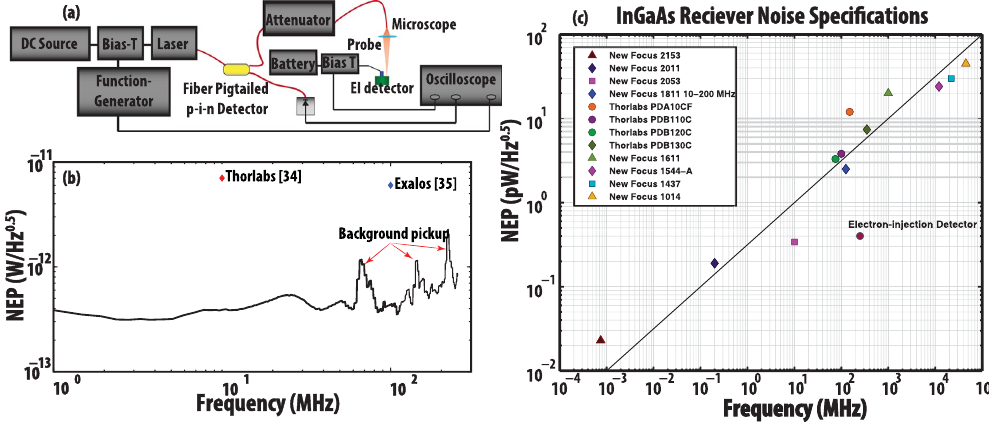
Figure 1. ( a ) Small-signal homodyne setup for measurement of electron-injection detector responsivity. The spectral shot noise current of the EI detector was also measured in the same setup using a spectrum analyzer. Red lines show optical connections and black lines show electrical connections. ( b ) The extracted noise equivalent power of the EI detector versus frequency. The noise equivalent power of the EI detector is as low as ~300 fW/ √ Hz at room temperature. The high-frequency peaks show the background pick up by the un-shielded probe. The noise equivalent power of two commercially available balanced detectors with a similar cutoff wavelength is also marked. NEP of the BDs is more than an order of magnitude higher than the EI detector. This suggests that to obtain same sensitivity, more than 2 orders of magnitude higher reference arm power should be used for the balanced detectors 34, 35 . ( c ) A comparison of the electron-injection detector noise equivalent power with a number of commercial detectors.